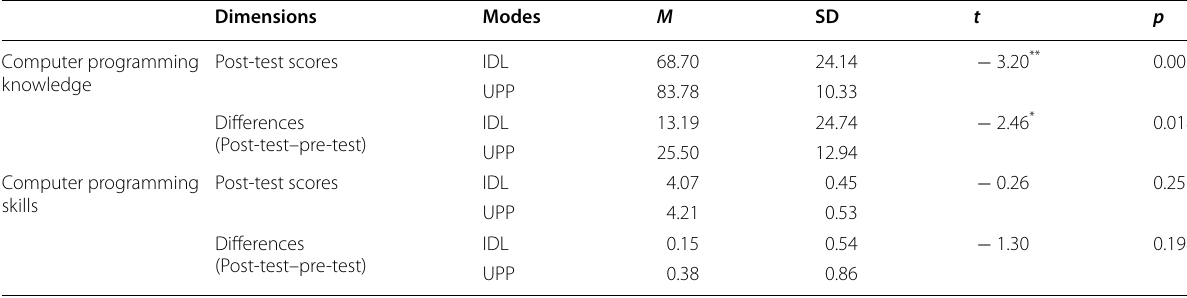
Table 2 Independent t test of post-test of computer knowledge and skills in two instructional modes